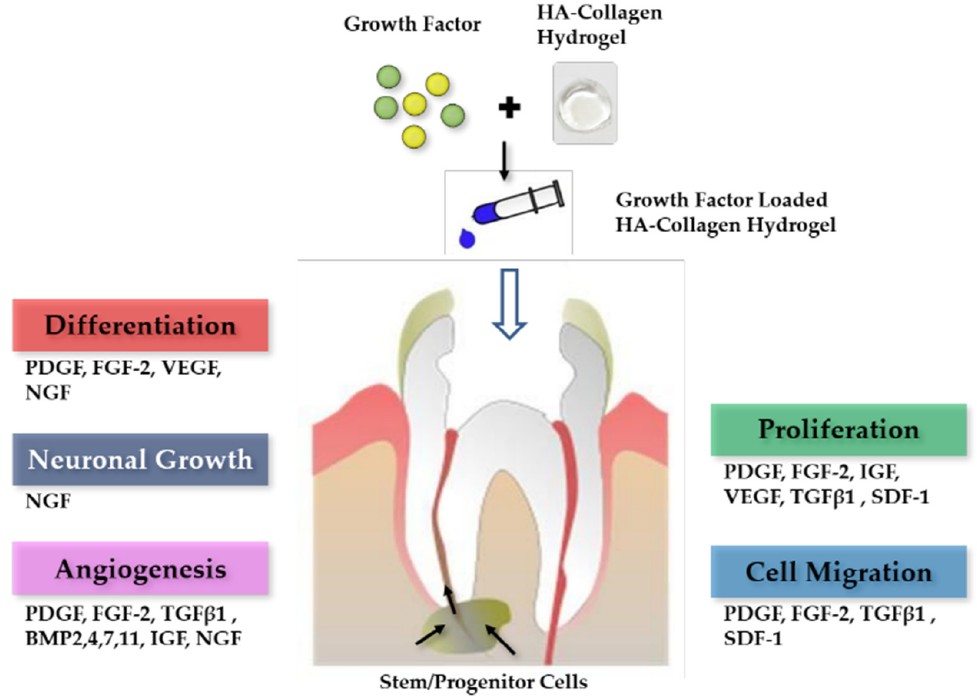
Figure 1. Signaling molecules for pulp regeneration. PDGF, platelet-derived growth factor; FGF, fibroblast growth factor; VEGF, vascular endothelial growth factor; NGF, nerve growth factor; TGF, transforming growth factor; BMP, bone morphogenetic protein; IGF, insulin-like growth factor; SDF, stromal cell-derived factor [1].